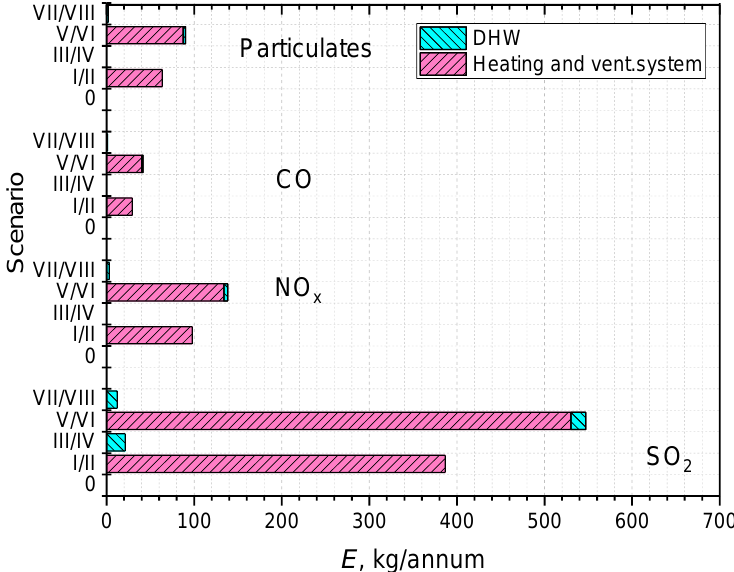
Figure 7. Environmental effect of thermal upgrading for the building and the scenarios: ‘0’—before; ‘I–VIII’—after thermomodernization (four pollutants).